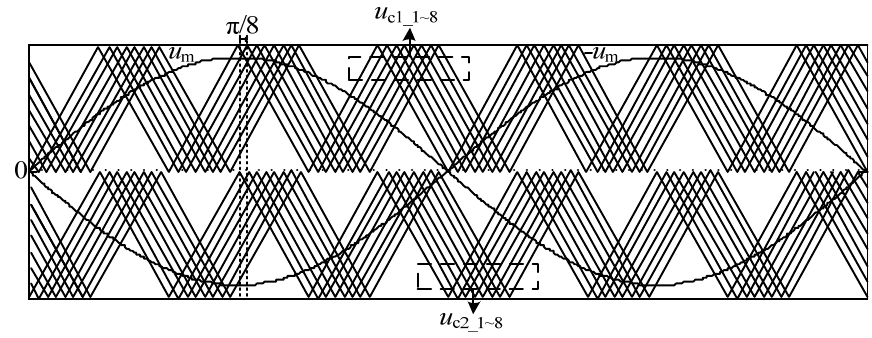
Figure 6. Phase shift carrier